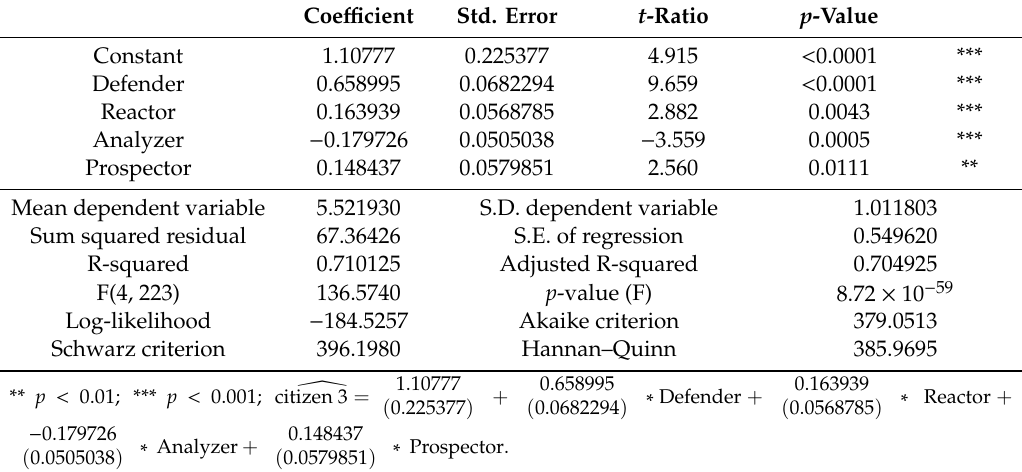
Table 3. Model 3: OLS, using observations 1–228. Dependent variable: Citizen 3.